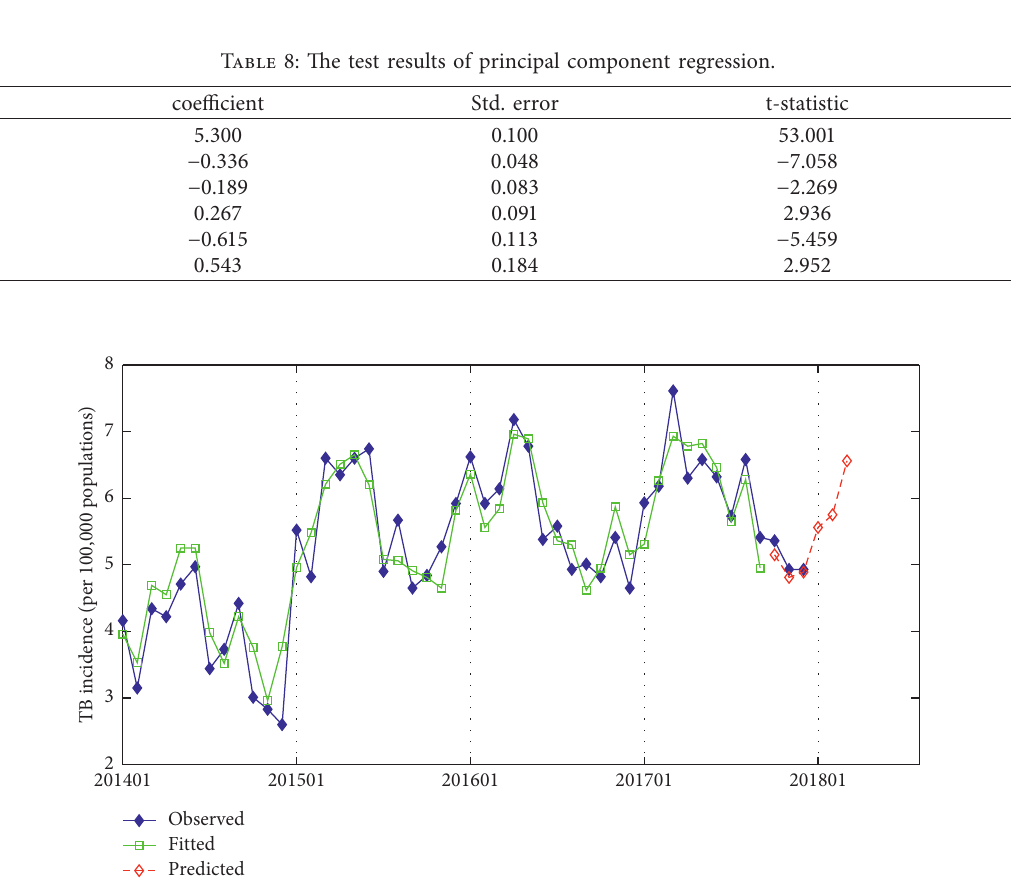
Figure 7: The comparison of fitting and prediction TB effects of ARMA (1, (1, 3))+